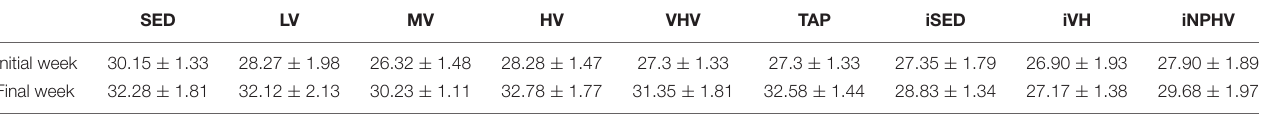
TABLE 2 | Body mass in mice subjected to regulated training for 10 weeks (SED, LV, MV, HV, and HVH) and 12 weeks (TAP, iSED, iVH, and iNPHV). SED LV MV HV VHV TAP iSED iVH iNPHV